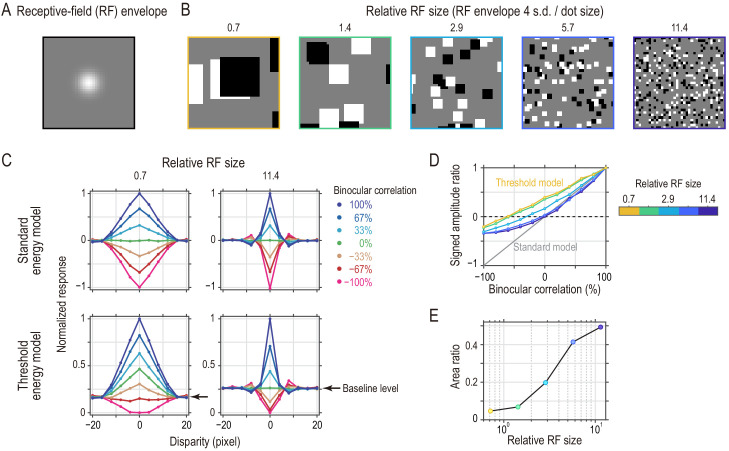
Threshold energy model with effectively smaller receptive fields (RFs) produces response patterns closer to match-based depth representation.(A) Gaussian envelope of a model RF (s.d., 2.86 pixels). We fixed the RF size in the simulations. (B) Random-dot stimuli with different spatial scales to simulate different relative RF sizes. The dot size ranged from 16 pixels to 1 pixel. (C) Disparity tuning curves from the standard energy model (top row) and those from the threshold energy model (bottom row). For the standard energy model, the response was defined as the binocular term of an energy-model complex unit. For the threshold energy model, these responses were half-wave rectified at each temporal frame. The tuning curves in each panel were normalized by the peak response (to 100% binocular correlation at zero disparity). Compare the simulated tuning curves to the pure correlation-based and match-based tuning shown in Figure 1B. (D) Signed-amplitude-ratio curves as a function of binocular correlation for different relative RFs. Compare the simulated results to the predictions shown in Figure 4A. The tuning amplitude was calculated as the tuning peak (or trough) minus tuning baseline. The negative sign indicates inverted tuning. (E) Area ratios computed for the curves in the threshold energy model in (D). The area ratio monotonically increased with the relative RF size.Figure 9—source data 1.Data for Figure 9C (disparity tuning).Figure 9—source data 2.Data for Figure 9D (signed-amplitude ratios).Figure 9—source data 3.Data for Figure 9E (area ratios).